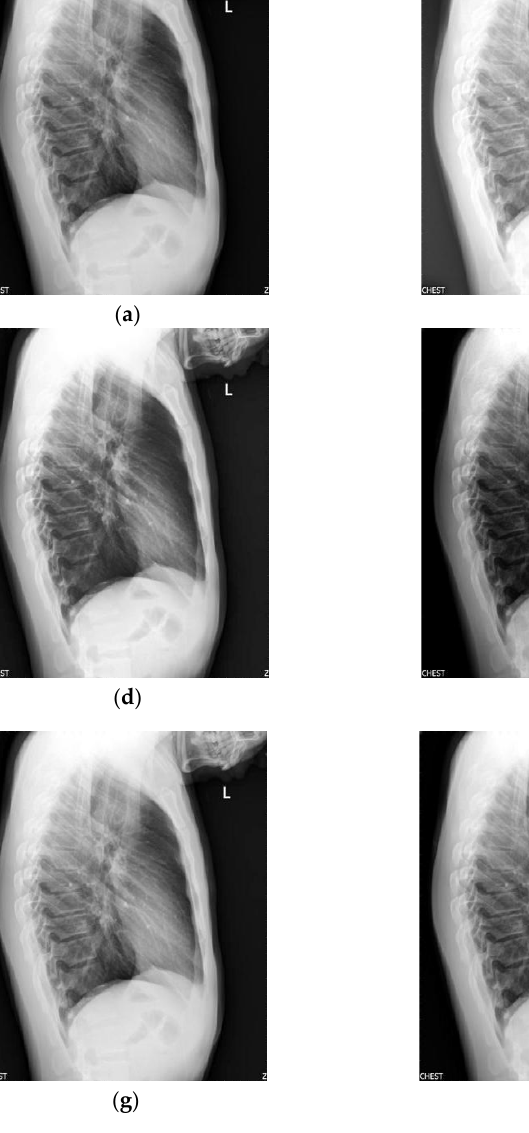
Figure 3. Comparison on X-ray image 3. ( a ) Original image; ( b ) McCann; ( c ) RLBHE; ( d ) RESIHE; Table 3. The metric data of eight methods on X-ray image 3.